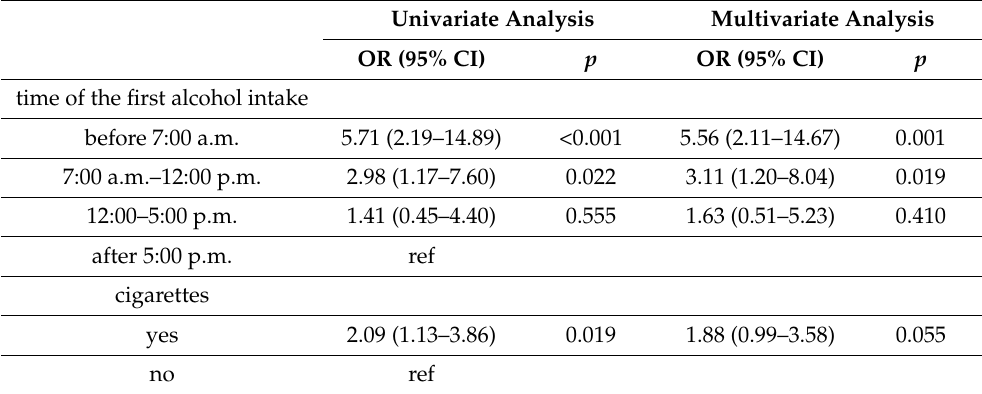
Table 2. Univariate and multivariate